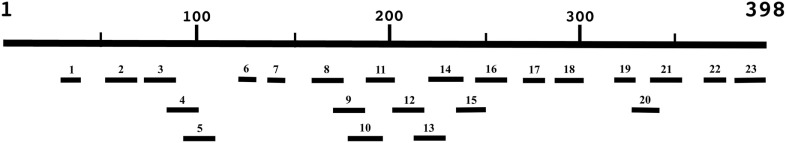
Schematic of 23 peptides generated based on the Clostridium perfringens alpha-toxin amino acid sequence (CAA35186.1). Linear peptides were selected based on the ease of synthesis using Immune Epitope Database and Analysis Resource publically available B-cell epitope prediction algorithms (figure not to scale) (17).